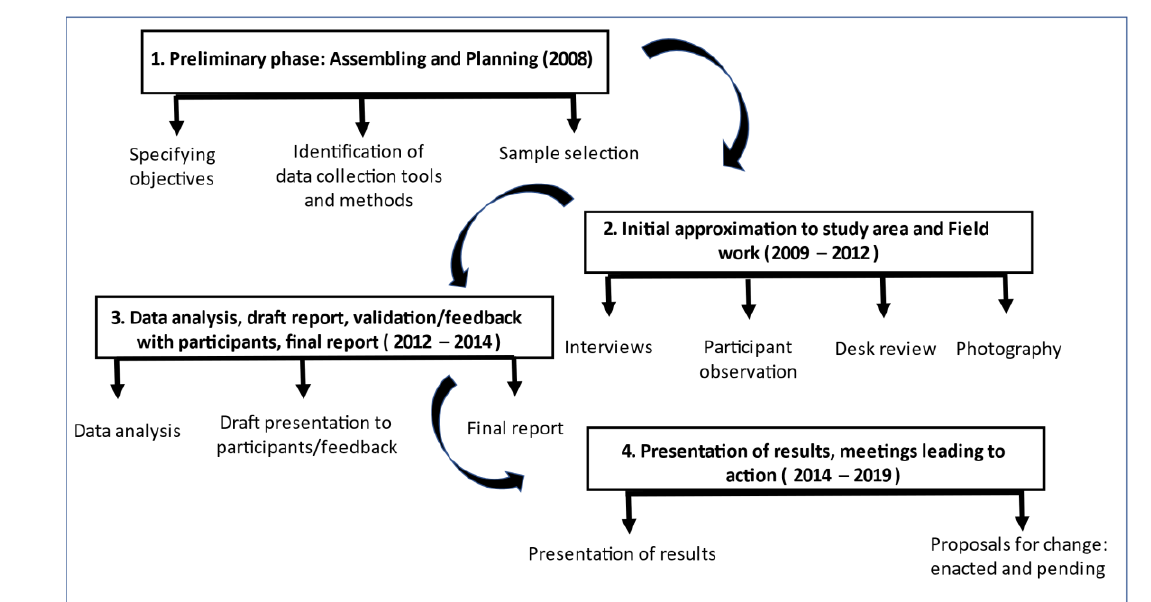
Figure 1. Phases of fieldwork (2008 – 2019).